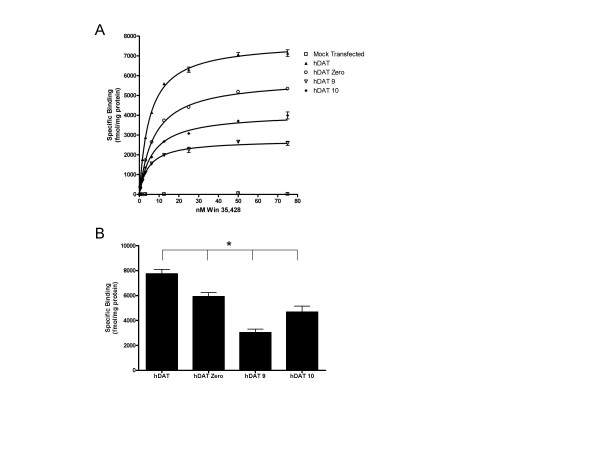
Comparative influence of 3'UTR variation on DAT saturation binding across three independent replicates. A) A characteristic binding curve revealing differences in Bmax attributable to DAT1 genotype. Mock-transfected negative control cells displayed no specific DAT binding. B) A one way ANOVA with Holm-Sidak post-hoc analysis demonstrated genotype-dependent differences in DAT density for all multiple comparisons (* = p < 0.05).